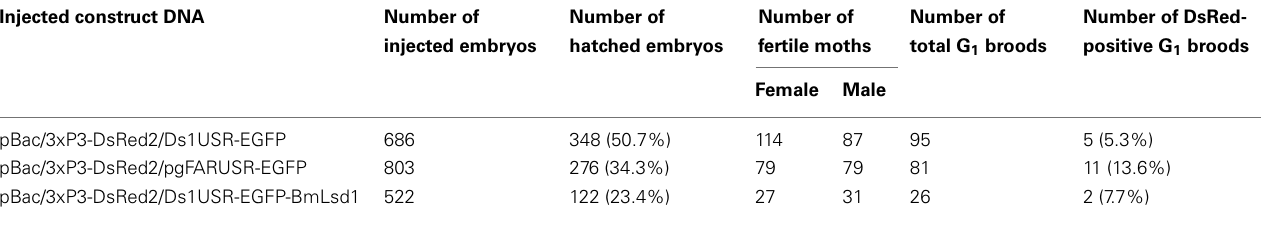
Table 3 | Results of construct DNA injections into pnd-w1 (RK) embryos. Injected construct